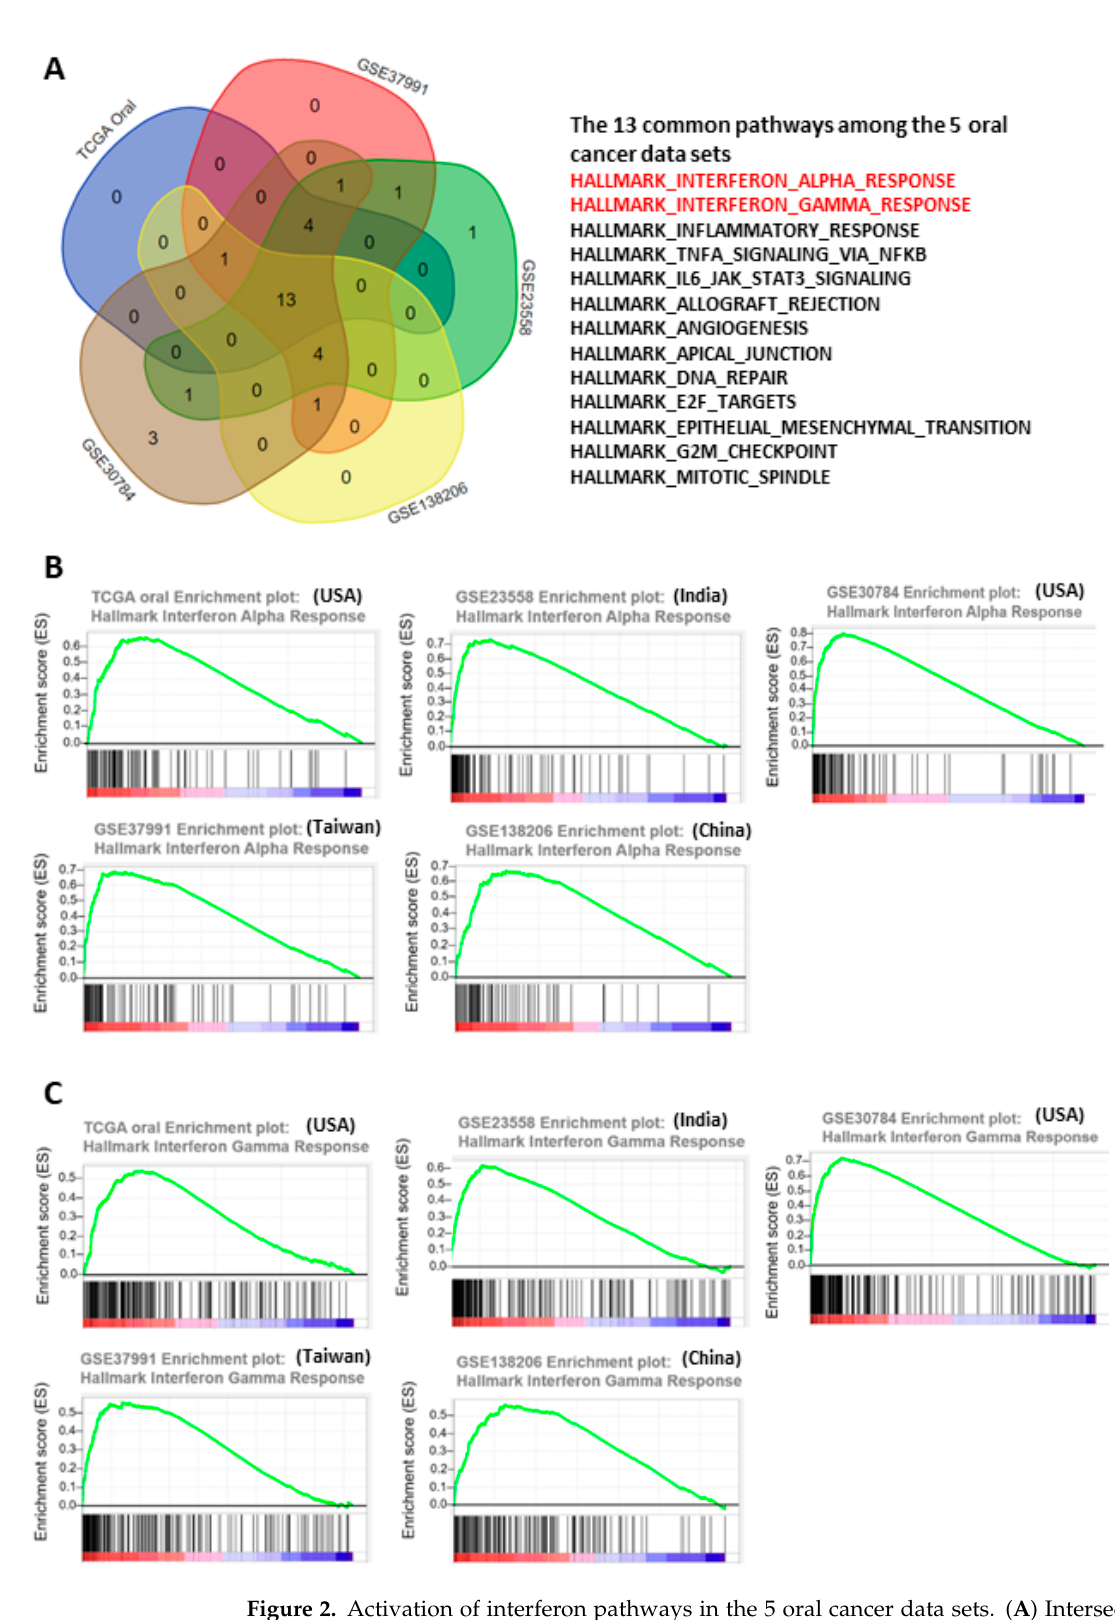
Figure 2. Activation of interferon pathways in the 5 oral cancer data sets. ( A ) Intersection of the upregulated molecular pathways among the 5 oral cancer data sets. ( B , C ) Enrichment plots of interferon- α ( B ) and interferon- γ ( C ) pathways in the 5 oral cancer data sets.